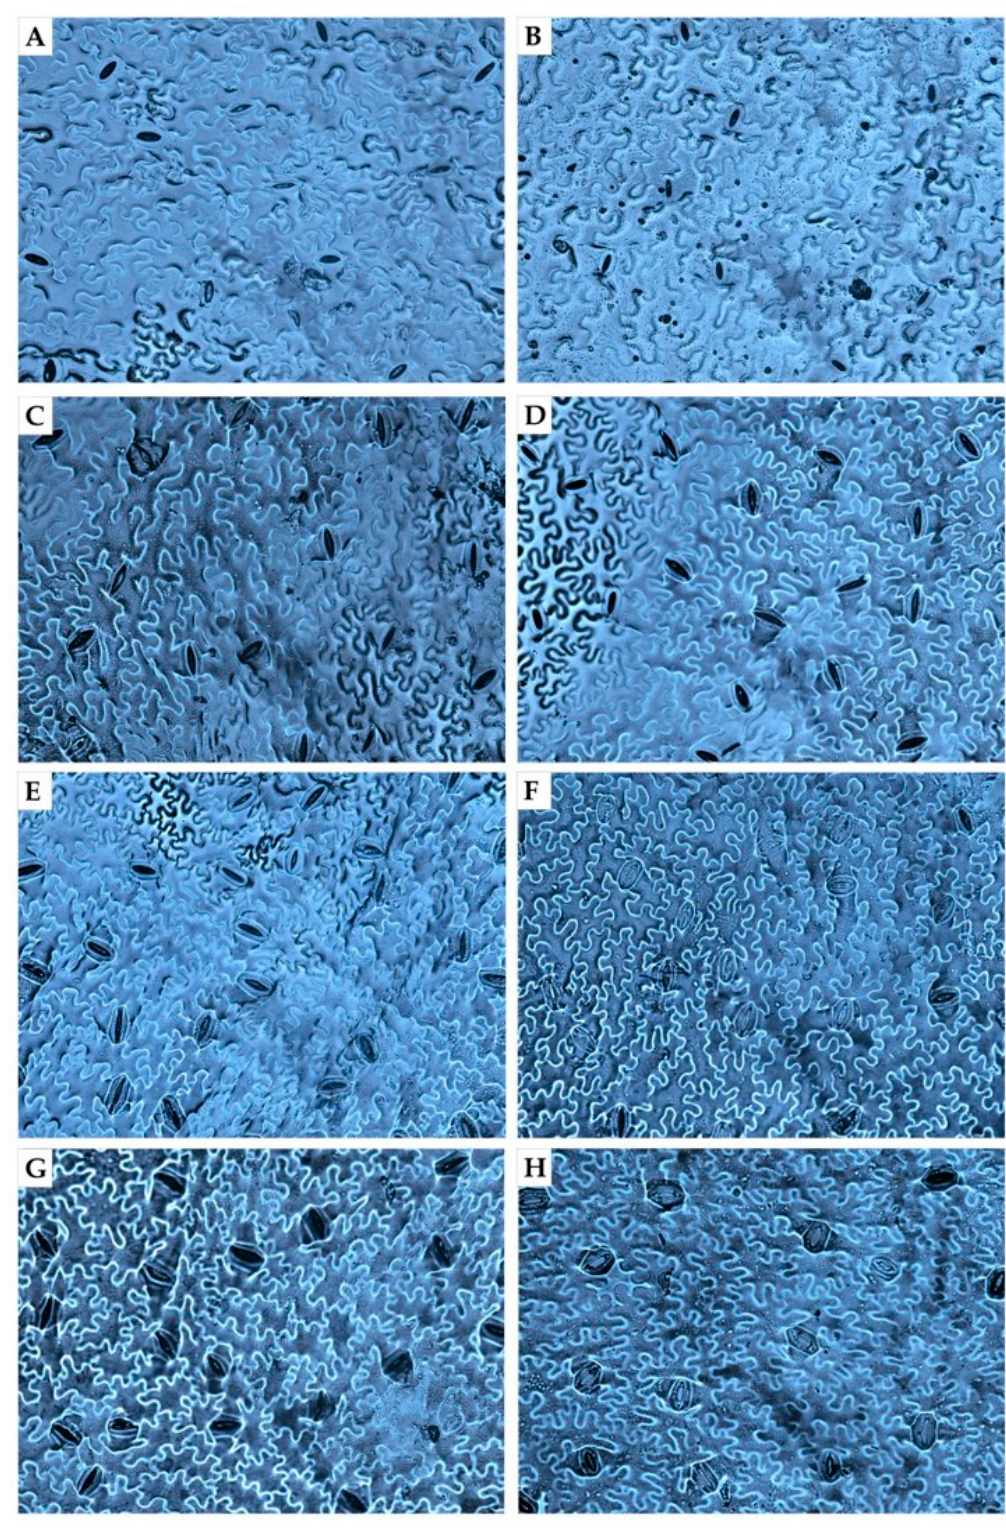
Figure 2. Illustrative microscopy images of the abaxial side of Lactuca sativa L. leaves in shaded and unshaded treatment (20 × ). Ballerina unshaded ( A ) and shaded ( B ); Canasta unshaded ( C ) and shaded ( D ); Oak leaf unshaded ( E ) and shaded ( F ); Romaine unshaded ( G ) and shaded ( H ).